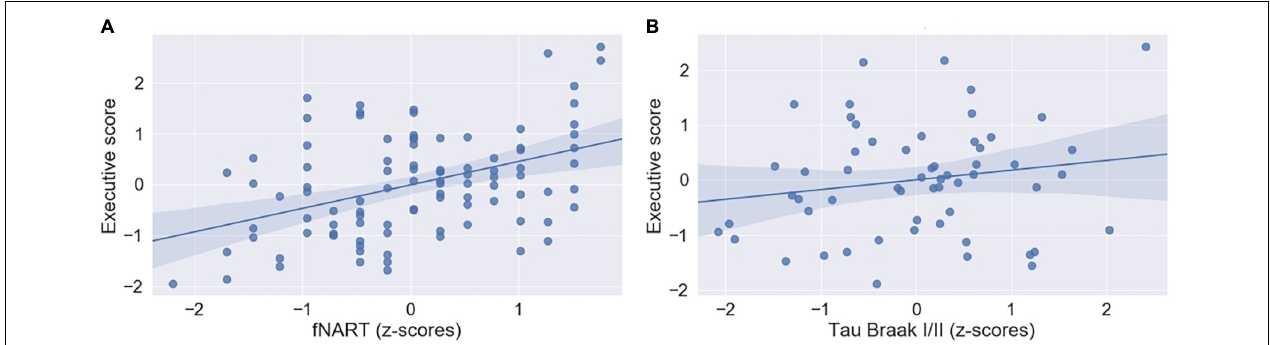
FIGURE 3 | (A) Scatter plot displaying association between executive functioning and fNART ( N = 101). (B) Scatter plot displaying association between executive functioning and tau level in Braak regions 1 and 2 ( N = 58). Regressions were used for visual display only and not as a substitute for full GLMM statistics.